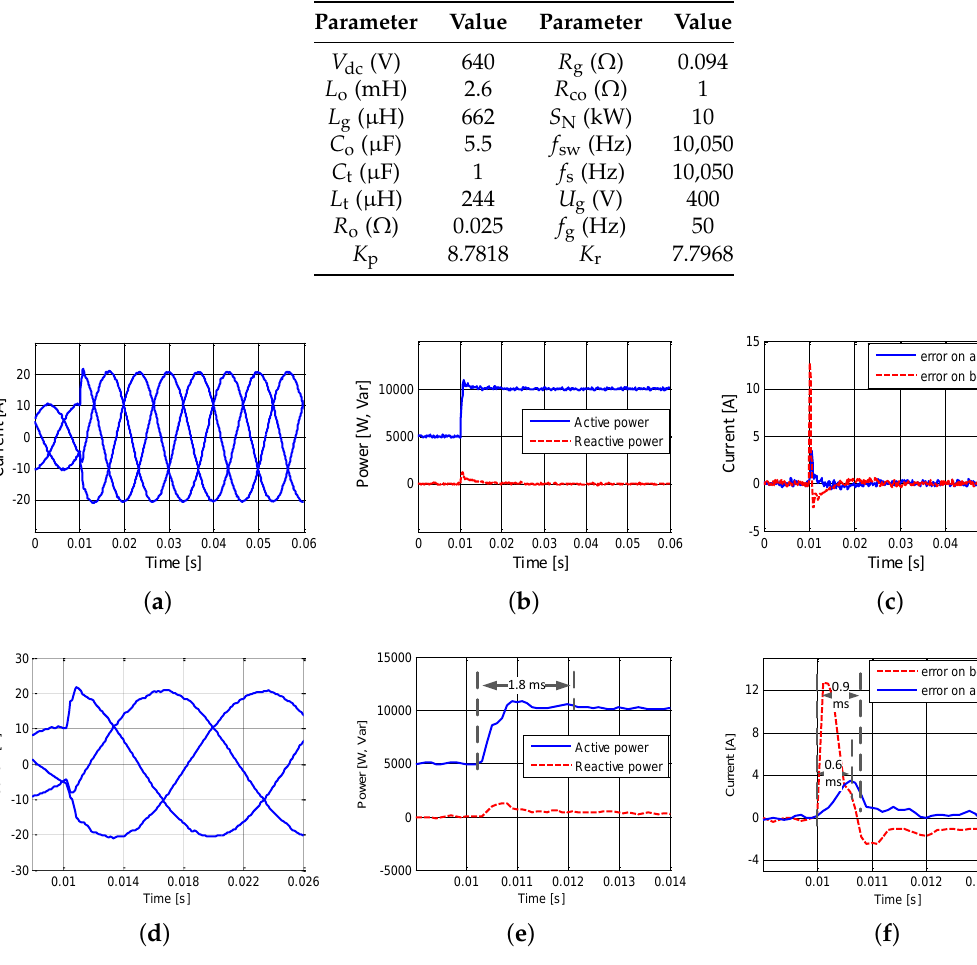
Figure 9. Simulated performance of the 10-kW system when active power reference jumps from 5 kW to 10 kW: ( a ) grid injected current; ( b ) instantaneous active and reactive power injection; ( c ) current control error on the α and β axis; ( d ) zoom-in view of ( a ); ( e ) zoom-in view of ( b ); and ( f ) zoom-in view of ( c